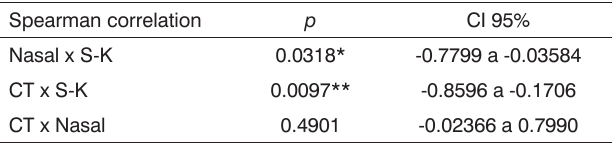
Table 2. Analysis of the correlation between the Shwachman - -Kulczycki (S-K) clinical score and tomographic and nasal endoscopic alterations, and correlation between nasal endos - copy and paranasal sinuses CT findings.